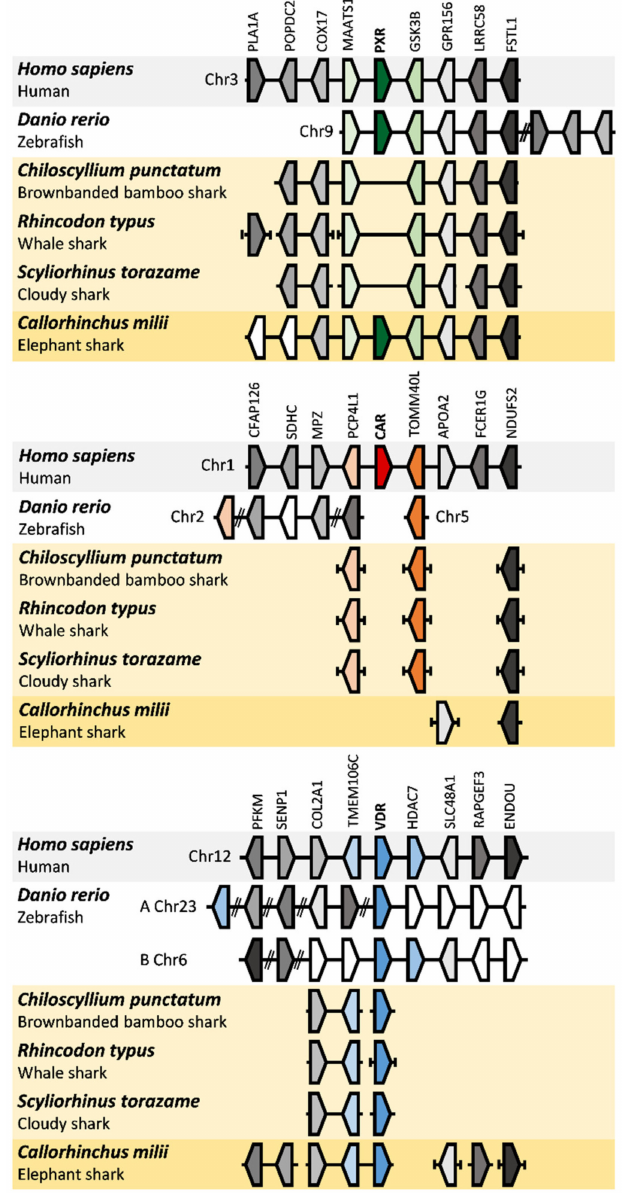
Figure 2. Schematic representation of syntenic pregnane X receptor ( PXR ), constitutive androstane receptor ( CAR ), and vitamin D receptor ( VDR ) regions. Human, zebrafish, brownbanded bamboo shark, whale shark, cloudy catshark, and elephant shark genomic locations of VDR , PXR , and CAR genes. The genomic locations of human PXR , CAR , and VDR were used as reference and highlighted in grey. The double slashes in zebrafish chromosomes symbolize discontinuity in the chromosome representation. The sca ff olds with chondrichthyan orthologs were highlighted in yellow (dark yellow for elephant